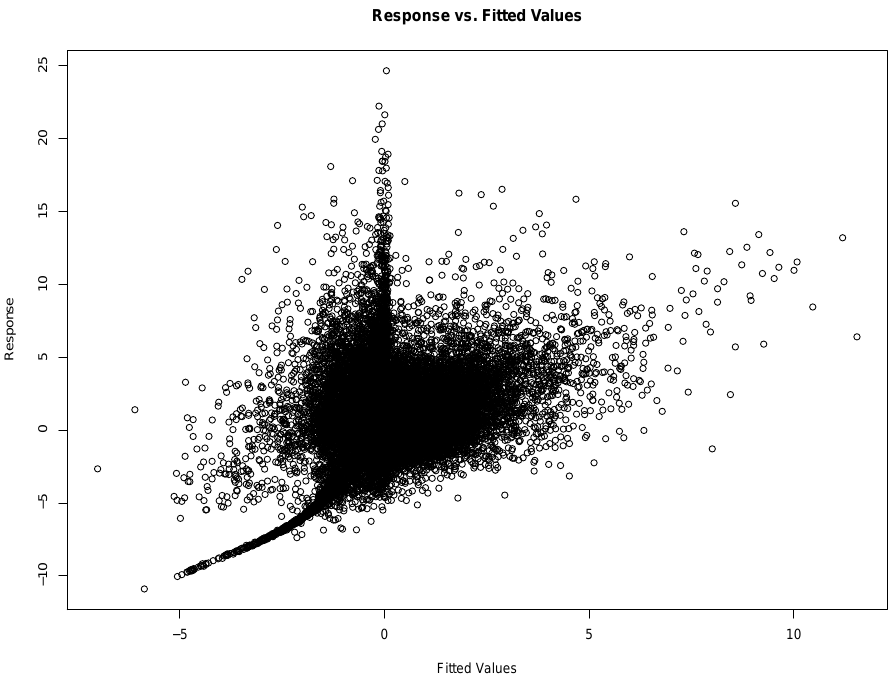
Figure A9. GAM Model Diagnostics (4). Table A1. Excess Mortality fit using GAM: estimated non-parametric components, with the corre- sponding effective degrees of freedom, F -statistic, and p -value.